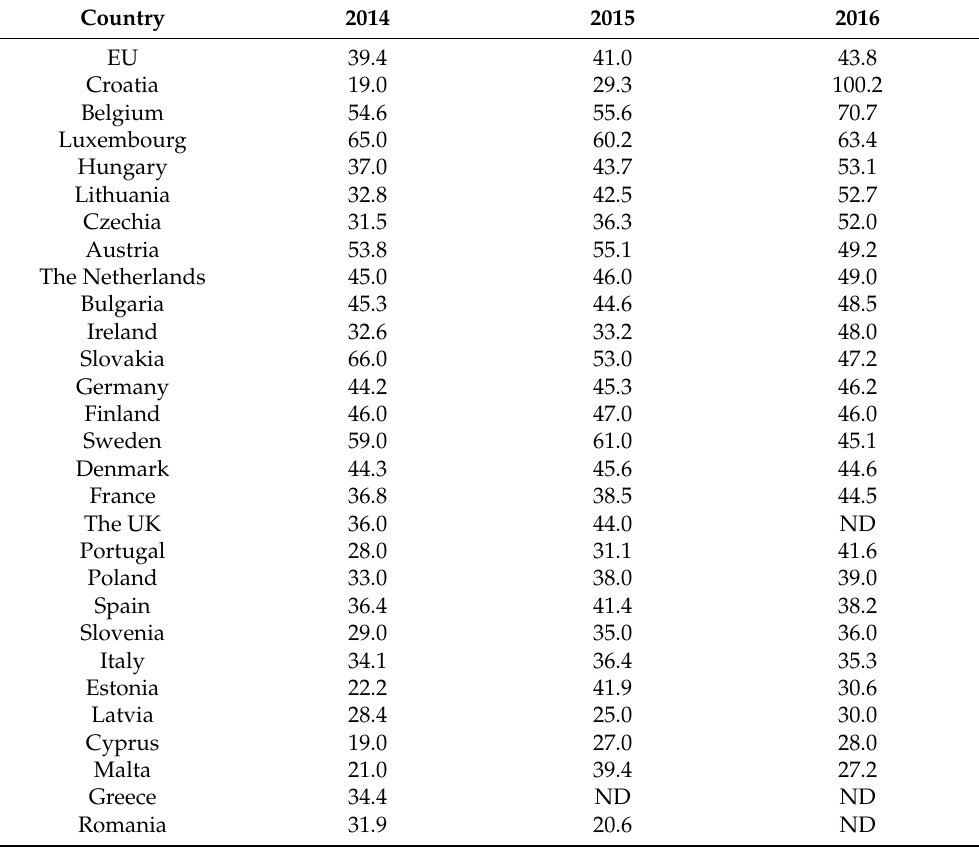
Table 1. EU and Member States collection rates in the years 2014–2016 (%).